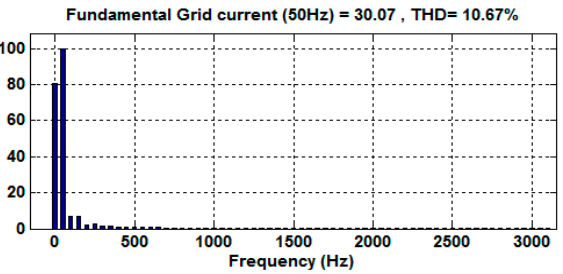
Figure 17. Grid output voltage harmonic profile. Energies 2018 , 11 , x FOR PEER REVIEW